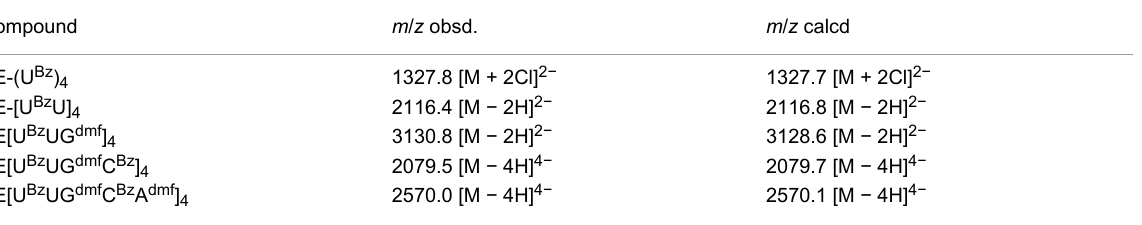
Table 1: Negative ion ESIMS of the tetrapodal pentaerythritol (PE) soluble support bearing 5'- O -deprotected oligonucleotides. Compound m / z obsd.